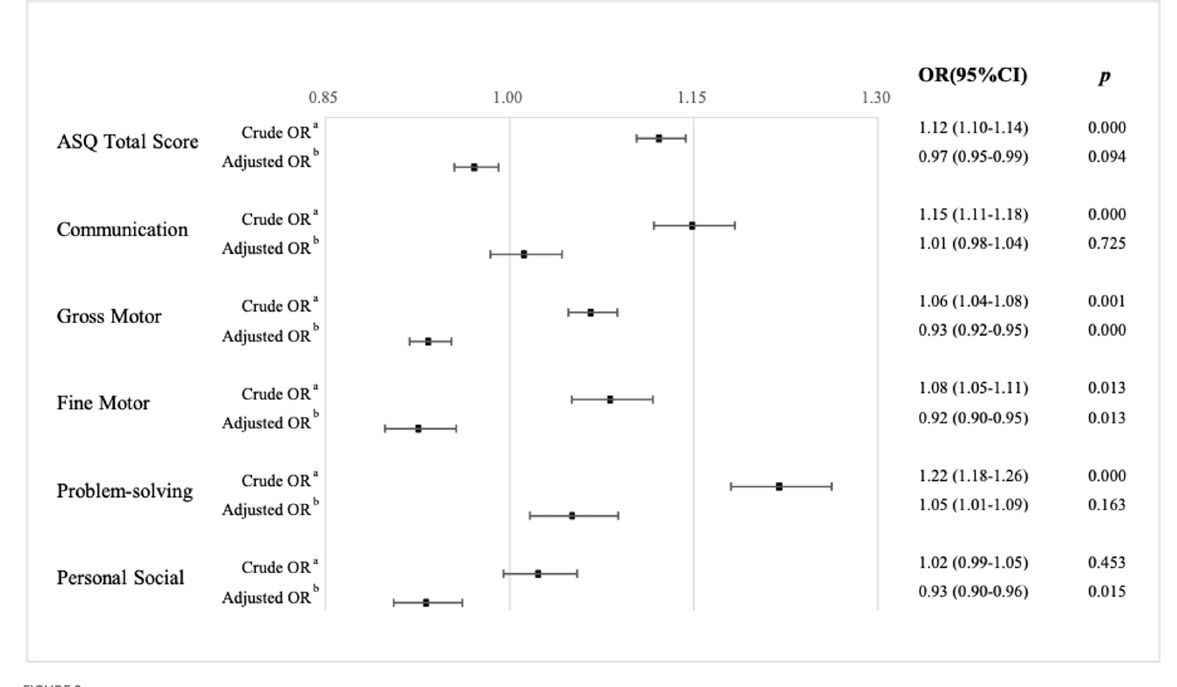
FIGURE 2 The association between sibling effect and risk of neurodevelopmental delays in preschoolers. a Adjusted for children’s general characteristics; b Adjusted for children’s general characteristics and socio-economical